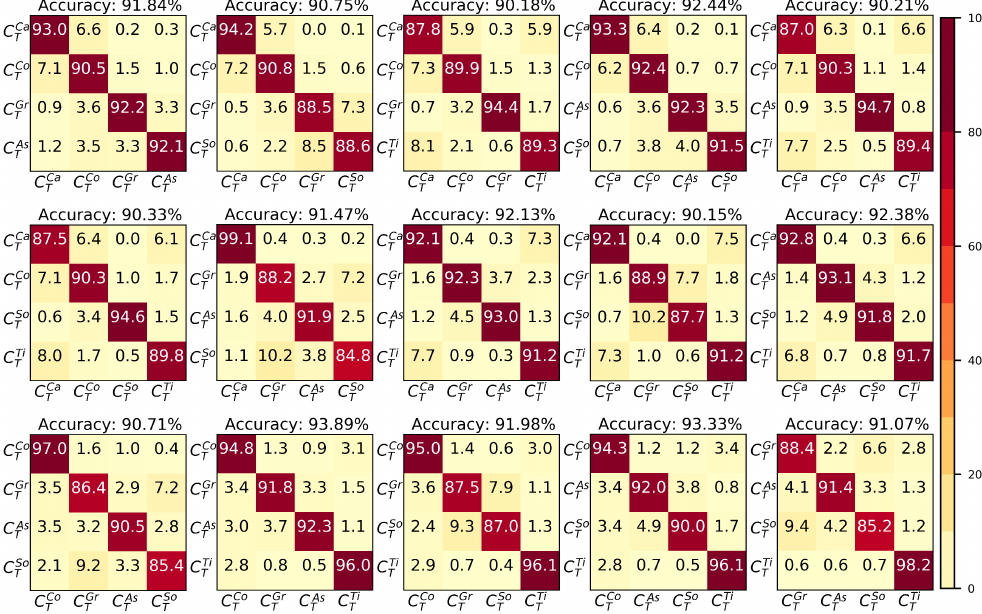
= carpet , C Co = concrete , T T